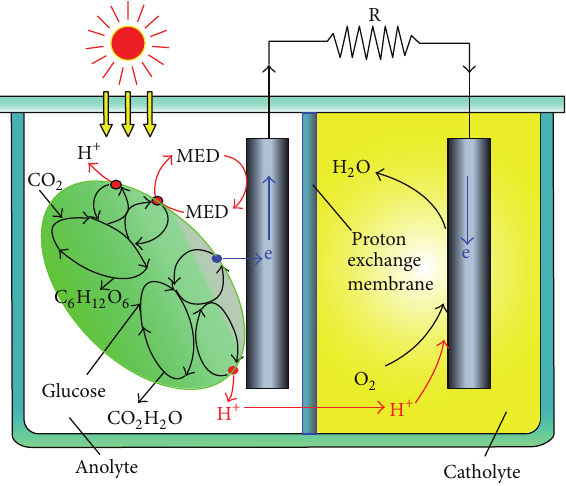
Figure 5: Current-timecurve of the spirulina biosolar cell under the light for 6 h.